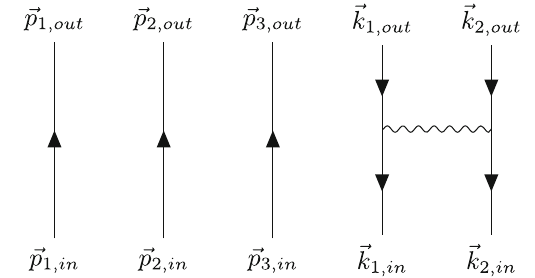
Fig. 3 A disconnected Feynman diagram contributing to I 2 for an ini- tial state of 3 electrons and 2 positrons